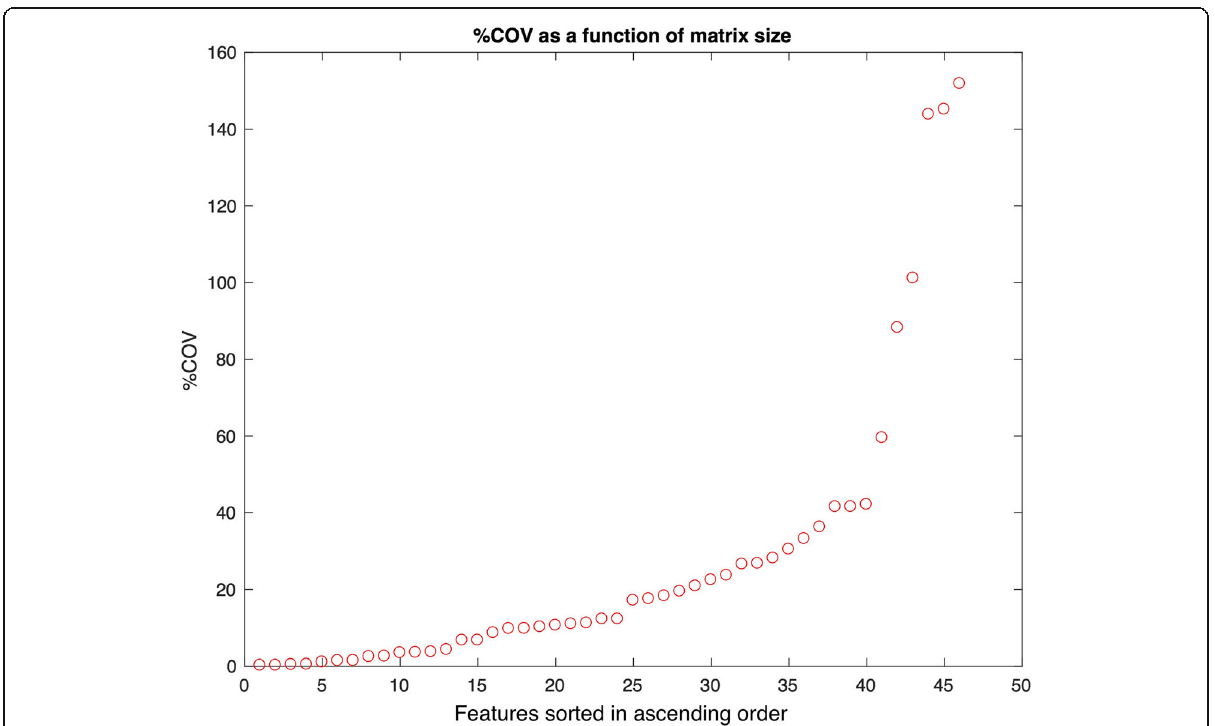
Fig. 2 Percentage coefficient of variation (%COV) as a function of spatial resolution (matrix size) for 46 features, (14 statistics and 32 texture features) sorted in ascending order. Of 46 features, 12 demonstrated a low robustness (%COV >